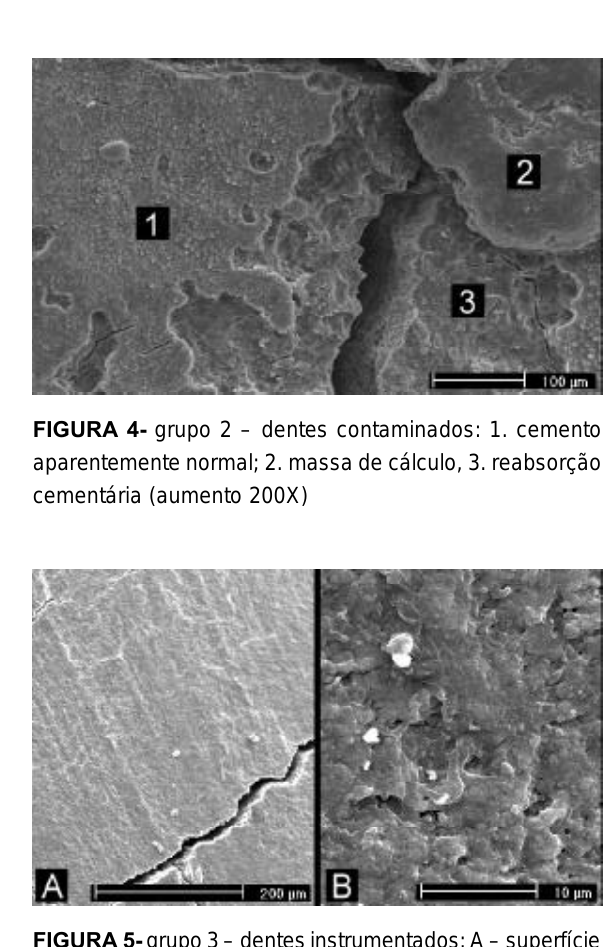
FIGURA 3- grupo 2 – dentes contaminados: A – cálculo bastante poroso; as estruturas circulares são o início de